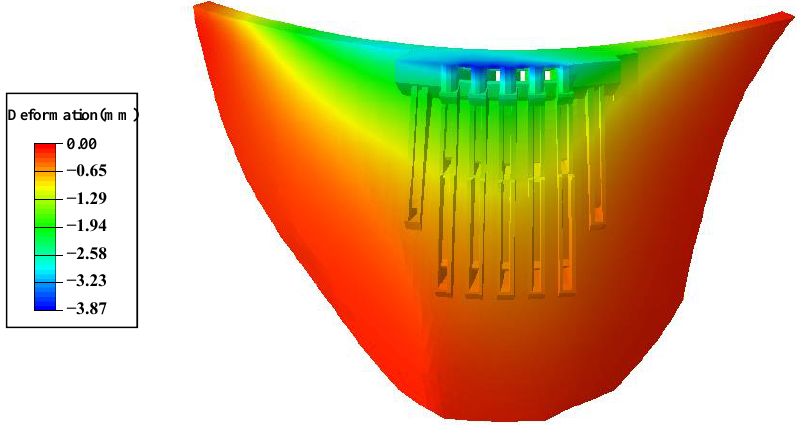
Figure 14. Dam annual cumulative radial deformation caused by solar radiation.